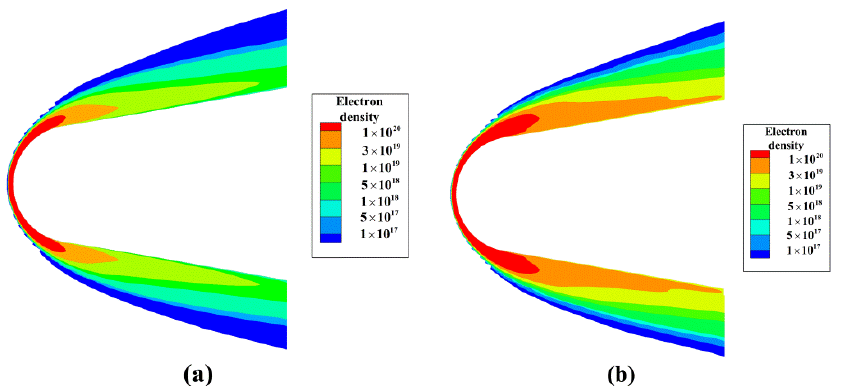
Figure 3. The electron density distribution in scenes 4 and 5. ( a ) Velocity is Mach 20. ( b ) Velocity is Mach 25.